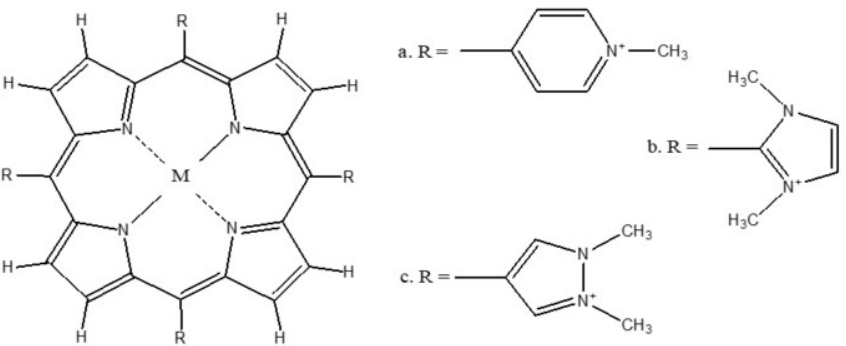
Figure 1. Structure of the cationic porphyrins ( a ) H 2 TMPyP, ( b ) H 2 TDMImP, and ( c ) H 2 TDMPzP, with M = H 2 for free-base porphyrin and Pb 2 + , Cd 2 + , Hg 2 + , Sn 4 + , As 3 + , and As 5 + for the complexes.